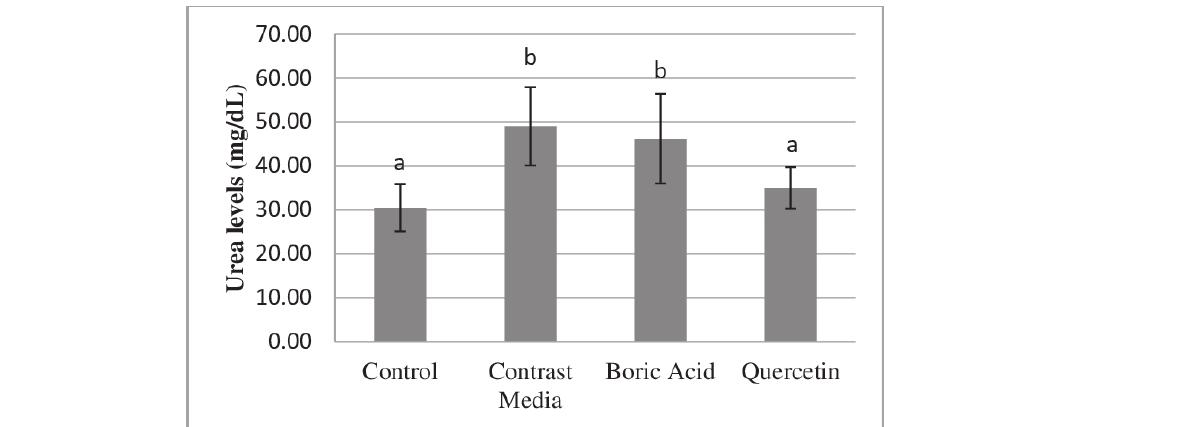
FIGURE 1 - Changes in serum urea levels among the groups in our study. Statistically insignificant differences are indicated by identical letters, and statistically significant differences are indicated by different letters. P <0.05 was considered statistically significant.